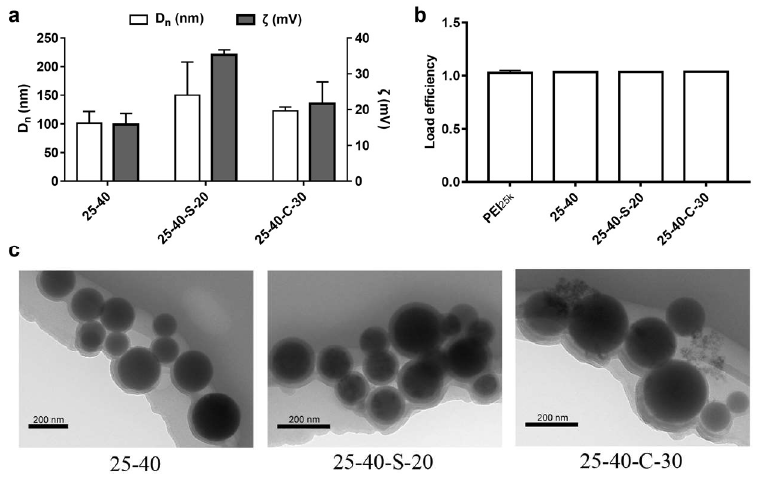
Figure 4. Characterizations of H-zPEI/siRNA NPs prepared at a polymer/siRNA mass ratio of 30:1. ( a ) Hydrodynamic diameters and zeta potentials of selected H-zPEI/siRNA NPs. ( b ) siRNA binding in selected NPs. ( c ) TEM images of selected NPs.